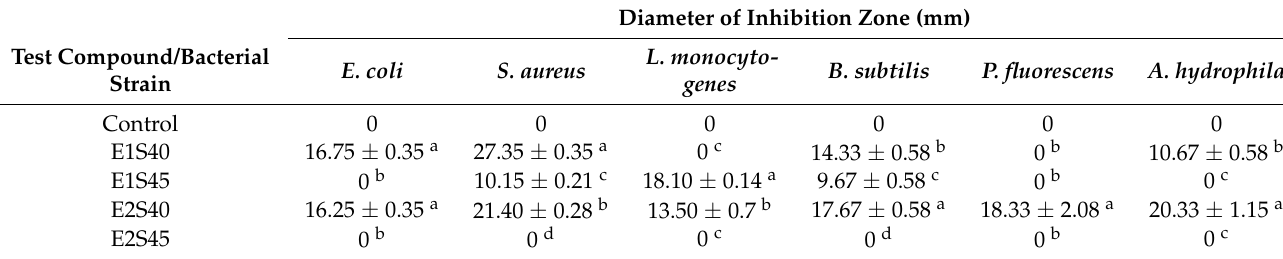
Table 3. Antibacterial effect of the tested extracts.